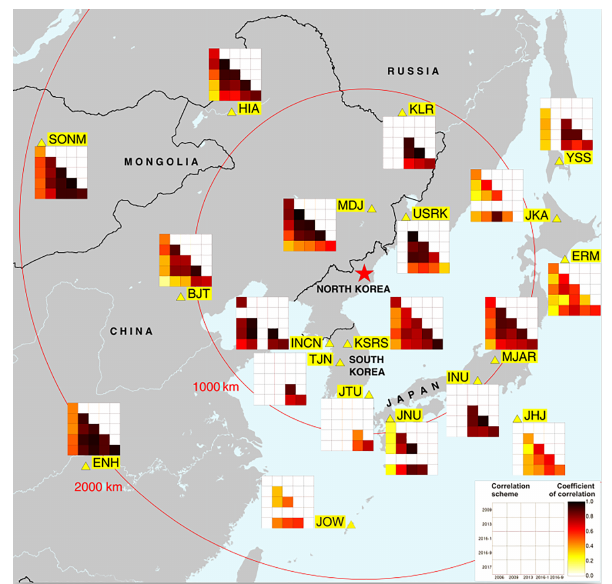
Figure 2. Maximum correlation coefficients for the coherence of the Pn phase for all available pairs of nuclear tests at 18 stations at regional distances of up to 2100km. Due to their similar size in ex- plosive yield, the four tests in the years 2009, 2013, and 2016 have a similar source mechanism and consequently show high maximum correlation coefficients between 0.70 and 0.99. The seismic signals for the 2006 and 2017 test are in general less correlated with the other tests due to the different source durations suspected for these two events. The 2006 and 2017 tests are the smallest and largest explosion,